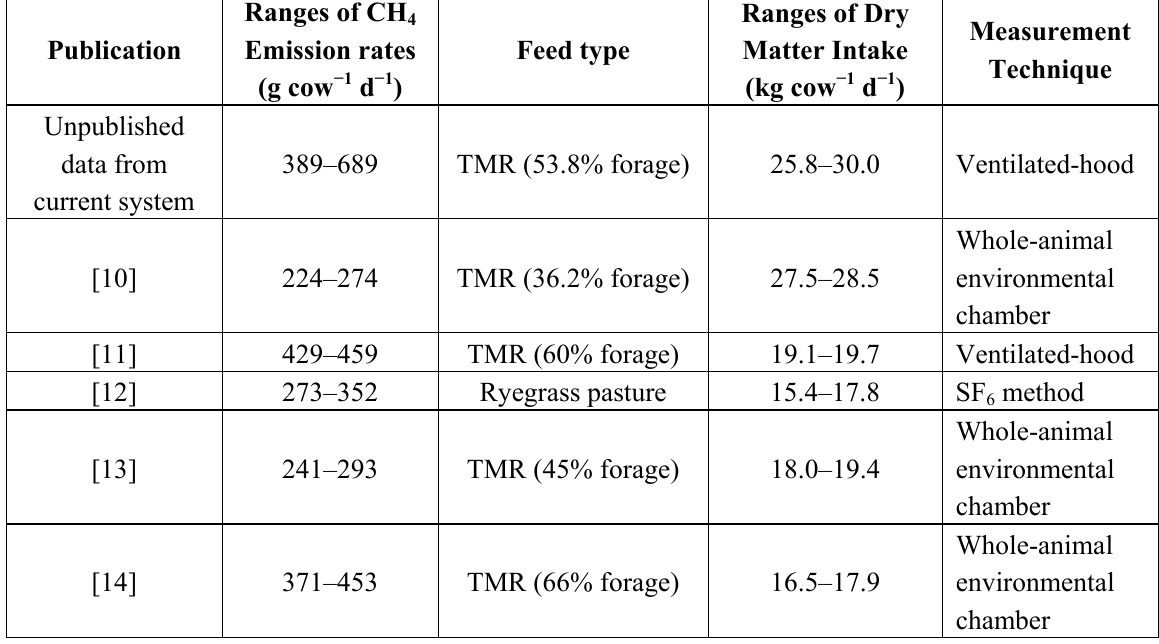
Table 3. A comparison of unpublished methane emission estimates (g cow − 1 day − 1 ) with selected recent publications for lactating Holstein dairy